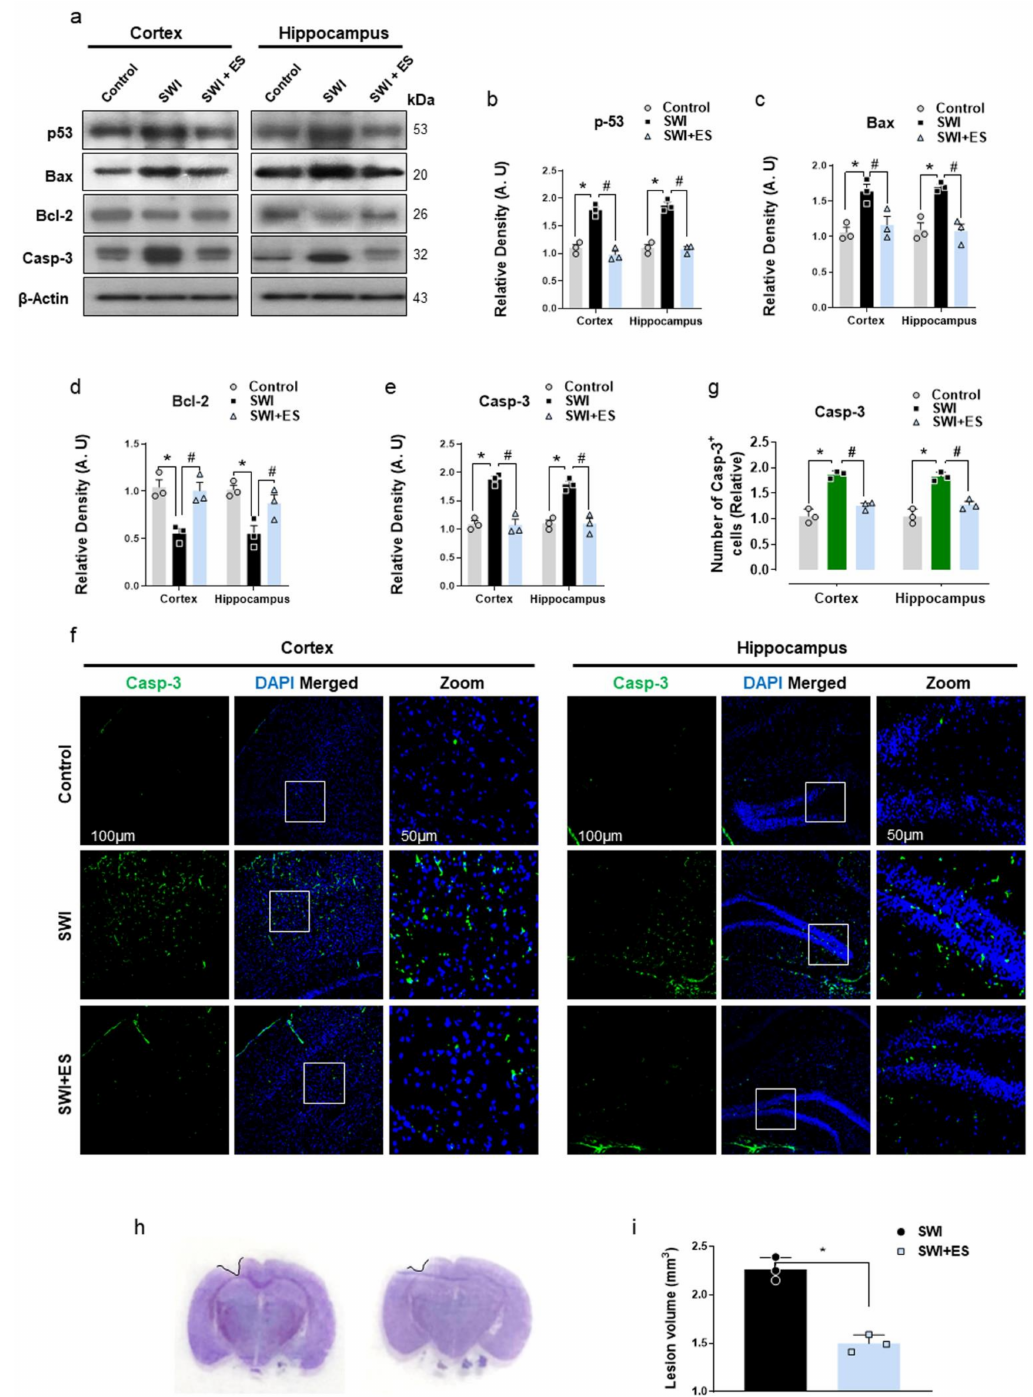
Figure 4. 17- β estradiol (ES) reduces cell death and neuronal apoptosis after SWI. ( a – e ) Western blot analysis showing protein expression of p-53, Bax, Bcl-2, and caspase-3 in the experimental groups. Anti- β -actin was used as a control for protein levels across the samples. The densities are expressed in arbitrary units (AU). ( f , g ) Brain slices from experimental animals revealing caspase-3 (green)-positive cells immunoreactivity stained with DAPI (blue) in the cortex and DG region. ( h , i ) Quantification of brain lesion volume at 7 days post-trauma in the SWI + ES-treated mice compared to the SWI group. Values are presented as means ± S.E.M. The data presented are relative to the control group. p -value < 0.05 was considered significant. * p < 0.05 vs. control group, # p < 0.05 vs. SWI + 17- β estradiol group. Bar = 50 µ m. Statistical significance was determined by one-way analysis of variance (ANOVA) followed by Tukey’s post-hoc analysis using the GraphPad Prism (ver. 8.0.2)